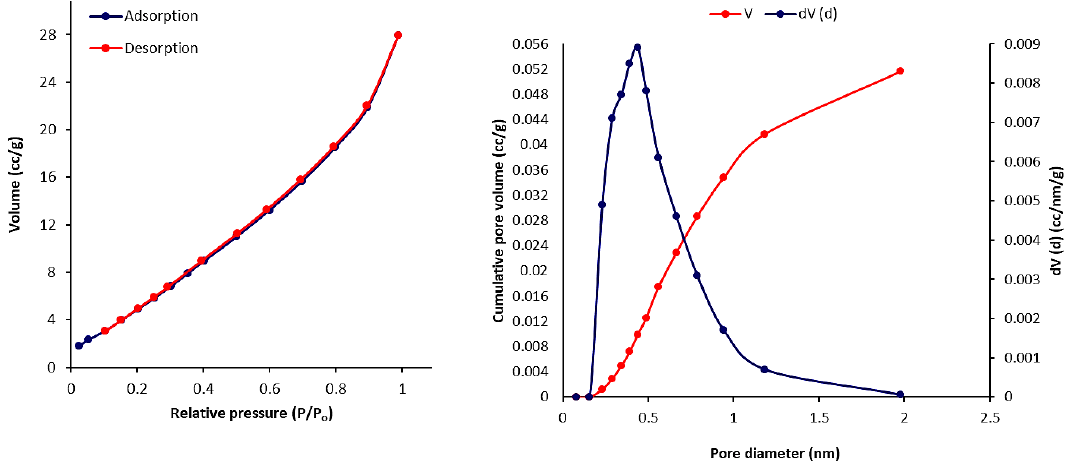
Figure 4. Adsorption–desorption isotherms of N 2 and pore size distribution curve for 5 .